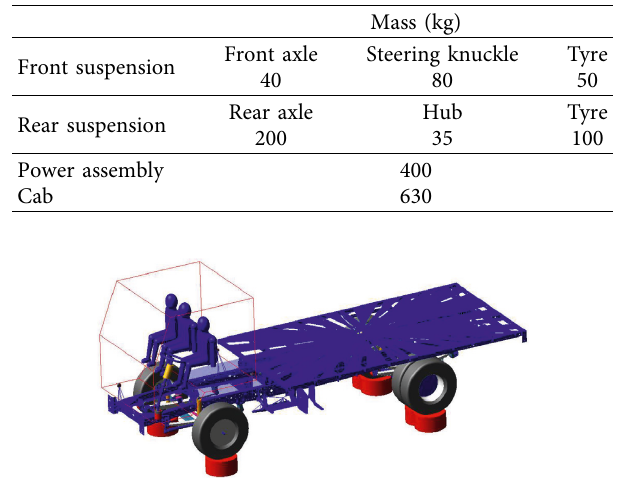
Figure 5: MBD model of the whole